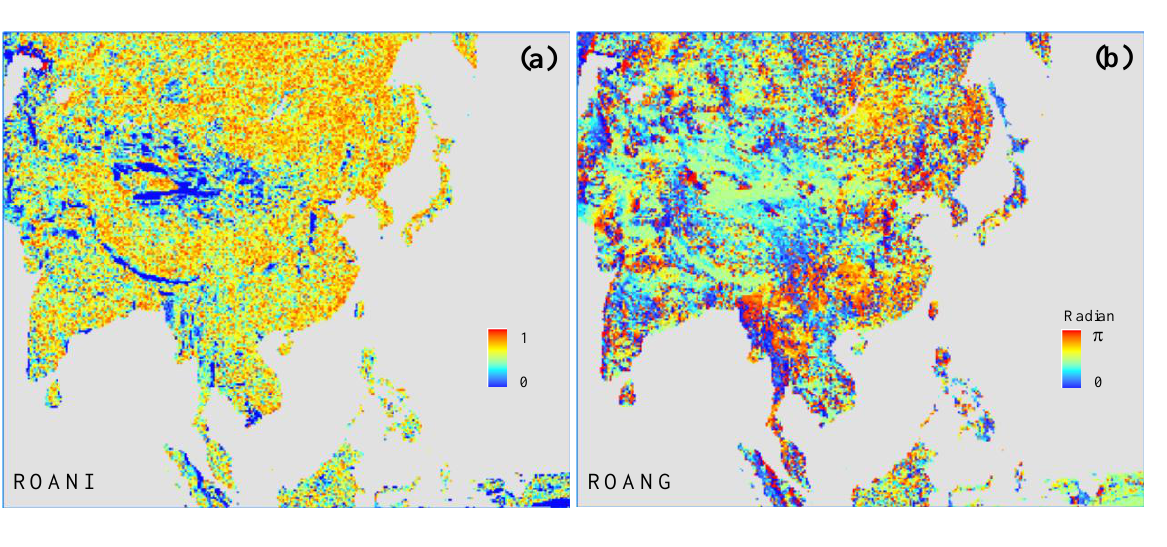
Figure 3. The geographic distributions of (a) anisotropy and (b) direction angle at resolved-scale over the Asia RCM